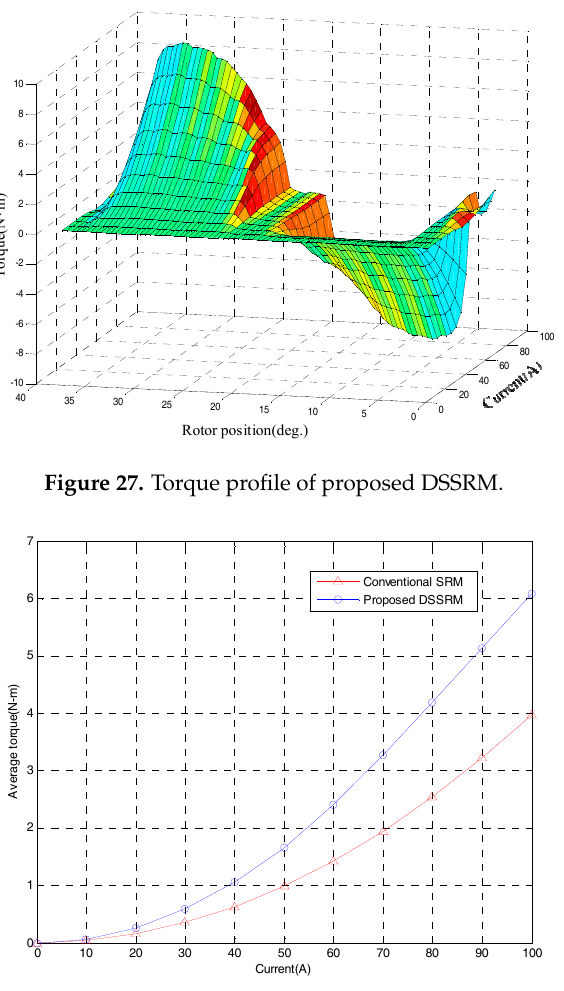
Figure 28. Average torque for conventional SRM and proposed DSSRM.